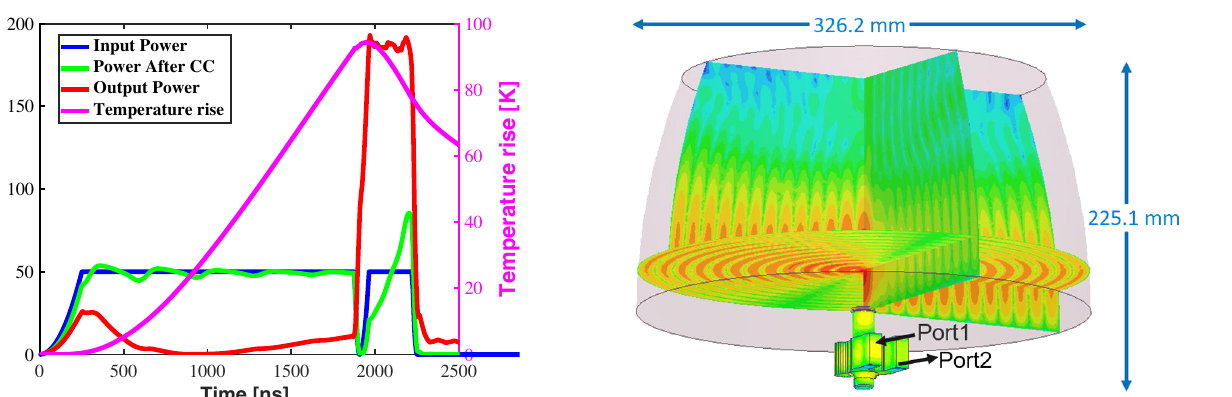
FIG. 16. Temperature rise of the storage cavity at 50 MW, 2250 ns input pulse. The blue, green, red, and pink are the input power, power after the correction cavity chain, output power, and temperature rise, respectively.